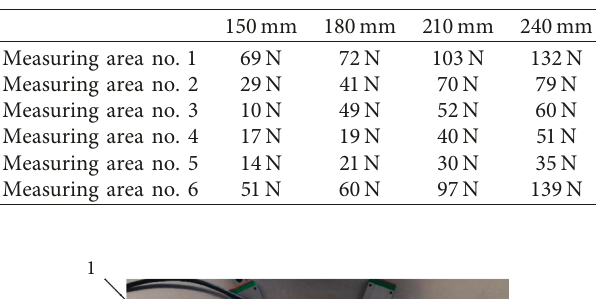
Figure 3: Simulation diagram. (a) Sensitivity of the structural parameters on the pressure of the roller group. (b) Weight of the structural parameters on the pressure of the roller group. Table 2: Pressure value of the roller group at 75% filling rate.